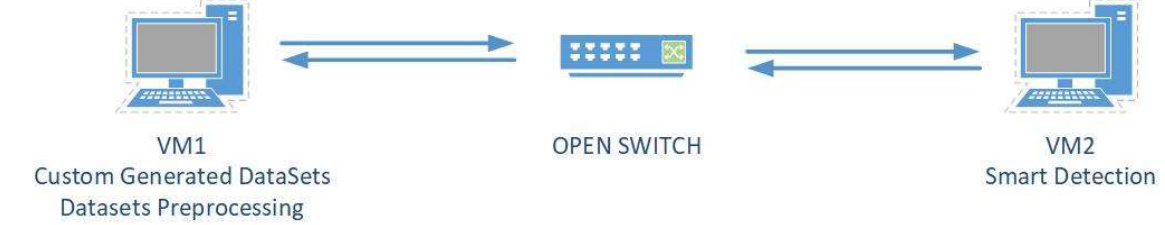
Figure 5. Detection validation system.